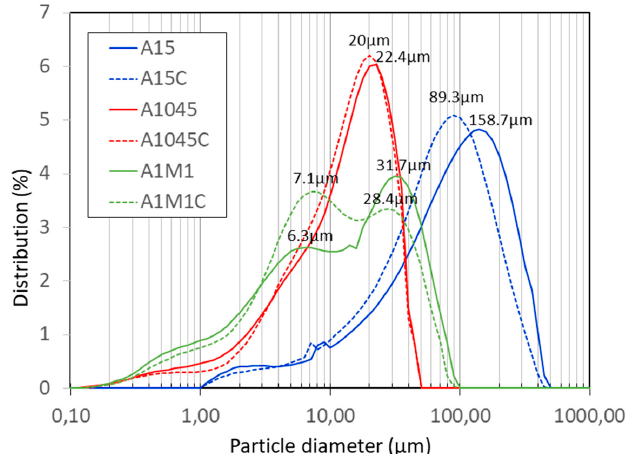
Figure 2. Grain-size distribution of calcites: A1045, A1M1, A15 and calcites calcined: A1045C, A1M1C, and A15C.